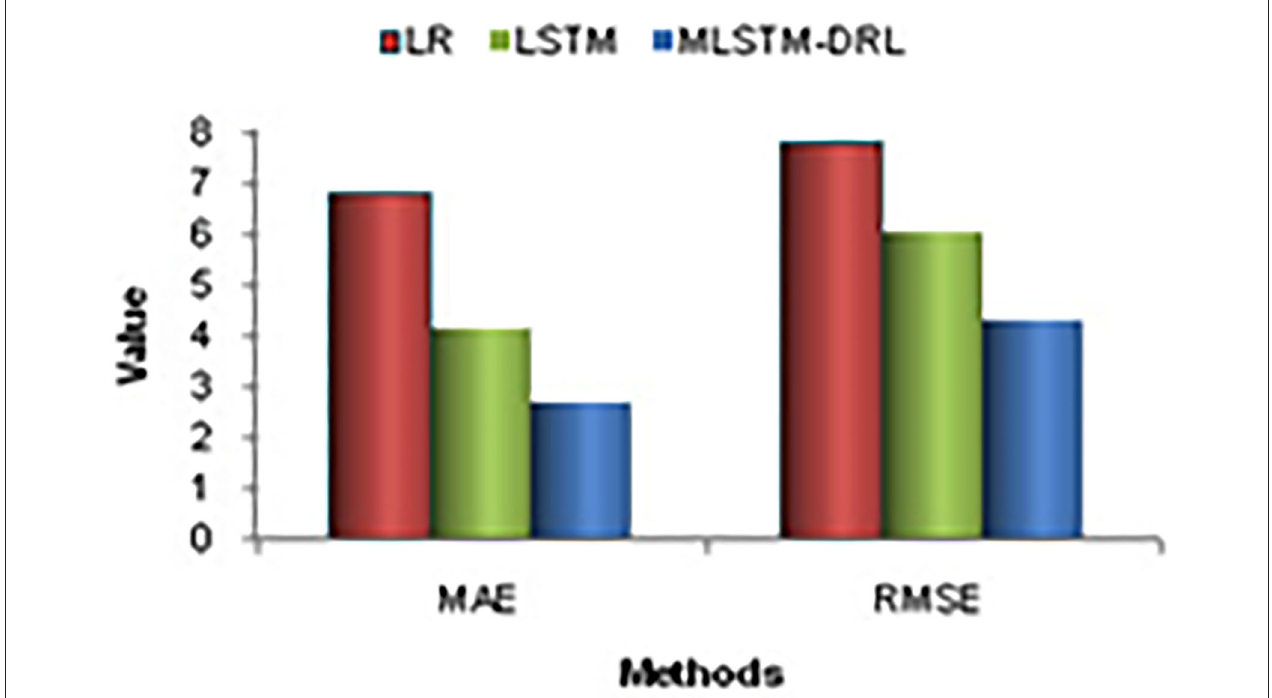
FIGURE 8 | Comparison of evaluation